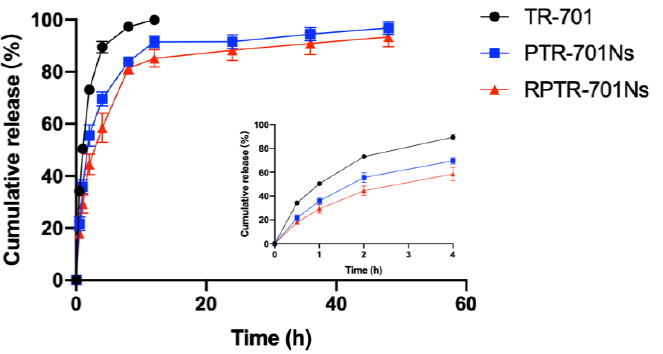
Figure 4. In vitro release of TR-701, PTR-701Ns and RPTR-701Ns. Data were presented as the mean ± SD ( n = 3).